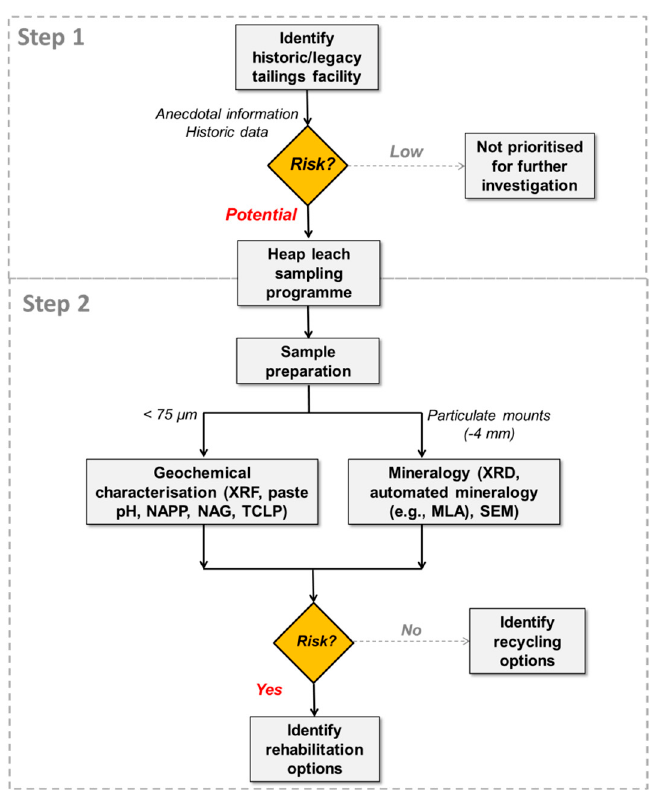
Figure 7. Proposed risk assessment framework for geoenvironmental characterisation of spent heap leach materials. If dealing with an abandoned site, Step 1 is mandatory, however, if characterising materials and an operational site, then it can be omitted. NB. This framework does not include an evaluation of the spent material’s physical properties.